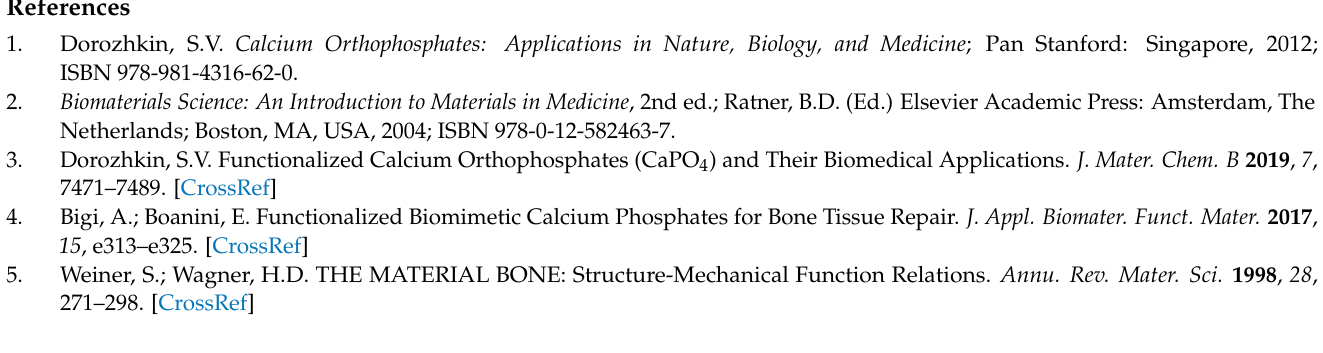
Figure S5: FTIR spectra and corresponding first- and second-order derivatives of calcium-deficient hydroxyapatite (CaDHA) formed in the control system and in the presence of bovine serum albumin or chitosan and TiO 2 (B)/titanate